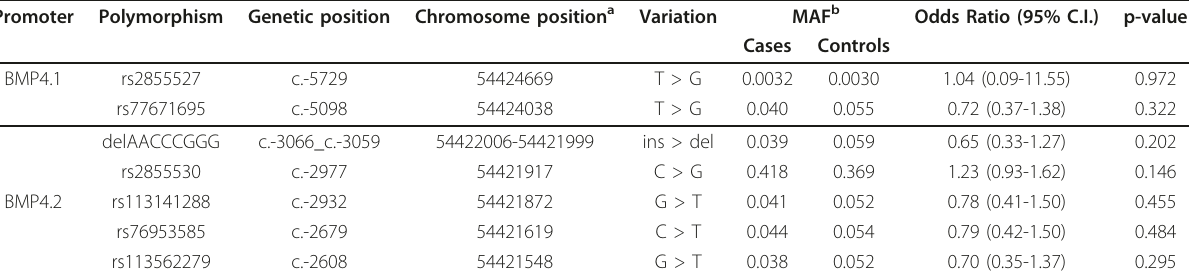
Table 1 Polymorphic variants detected within BMP4.1 and BMP4.2 in NSCLP cases and controls Promoter Polymorphism Genetic position Chromosome position a Variation